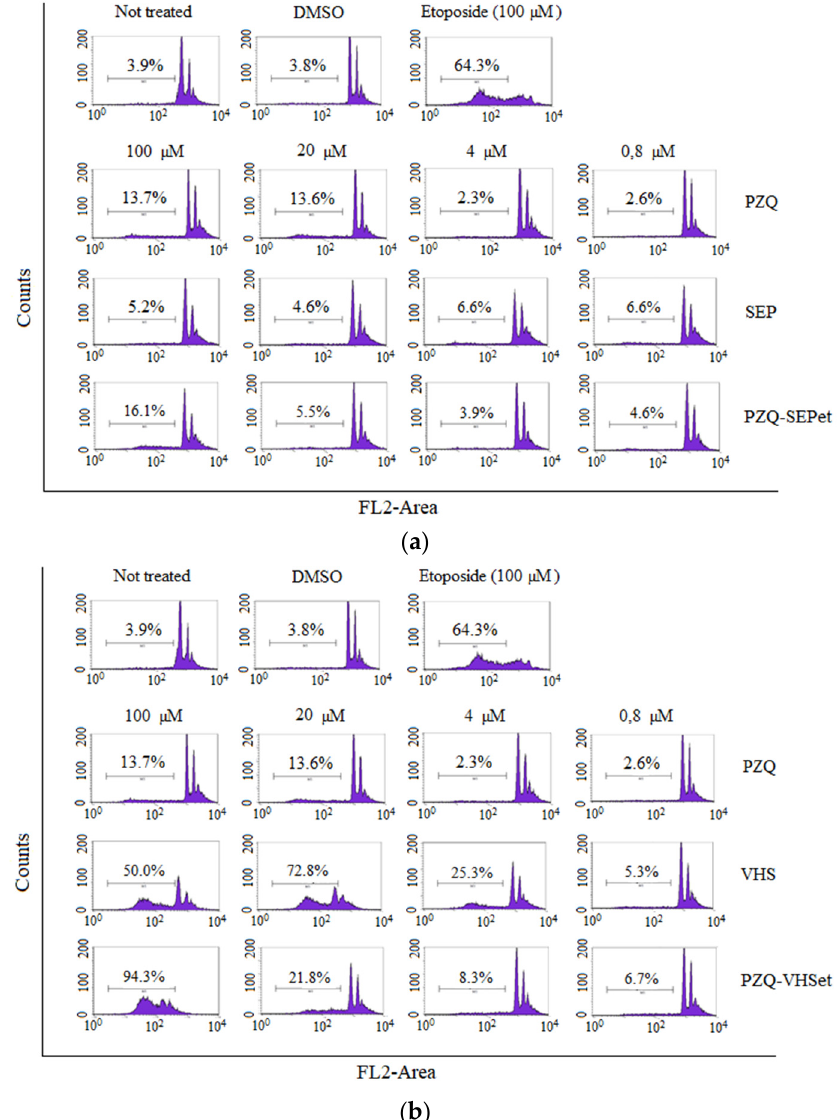
Figure 7. Cell cycle of the HCT116 line treated with the PZQ, SEP and PZQ–SEPet ( a ), and with the PZQ, VHS and PZQ–VHSet ( b ). The percentages indicate the number of cells in Sub-G1 (apoptotic or necrotic). Negative controls (Not treated and DMSO) and positive control (Etoposide) are also